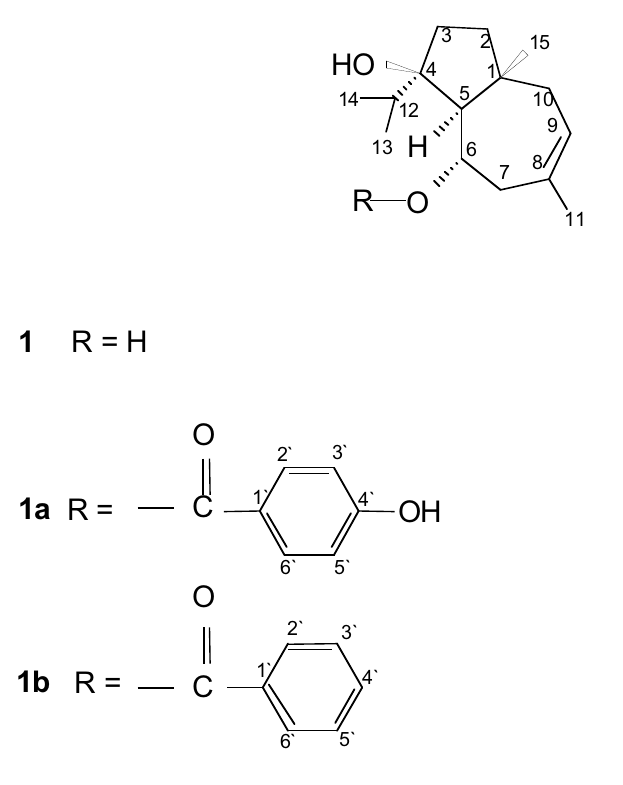
Fig. 1. Compounds extracted from the roots of Ferula harmonis . Based on the composition of R, structure 1 is jaeskeanadiol; 1a is ferutinin; and 1b is